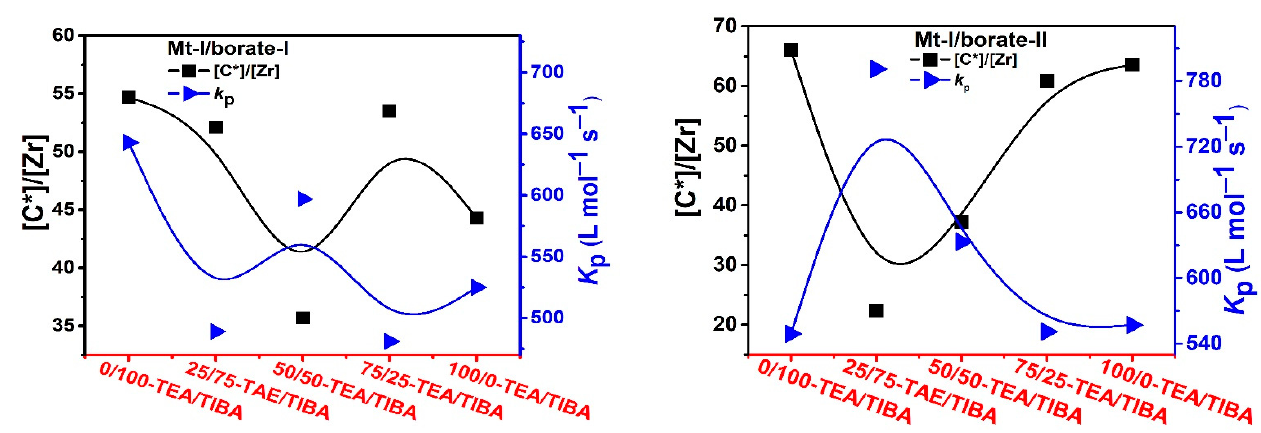
Figure 4. Active center ratio and k P of ethylene polymerization with Mt-I/borate/alkylaluminum.